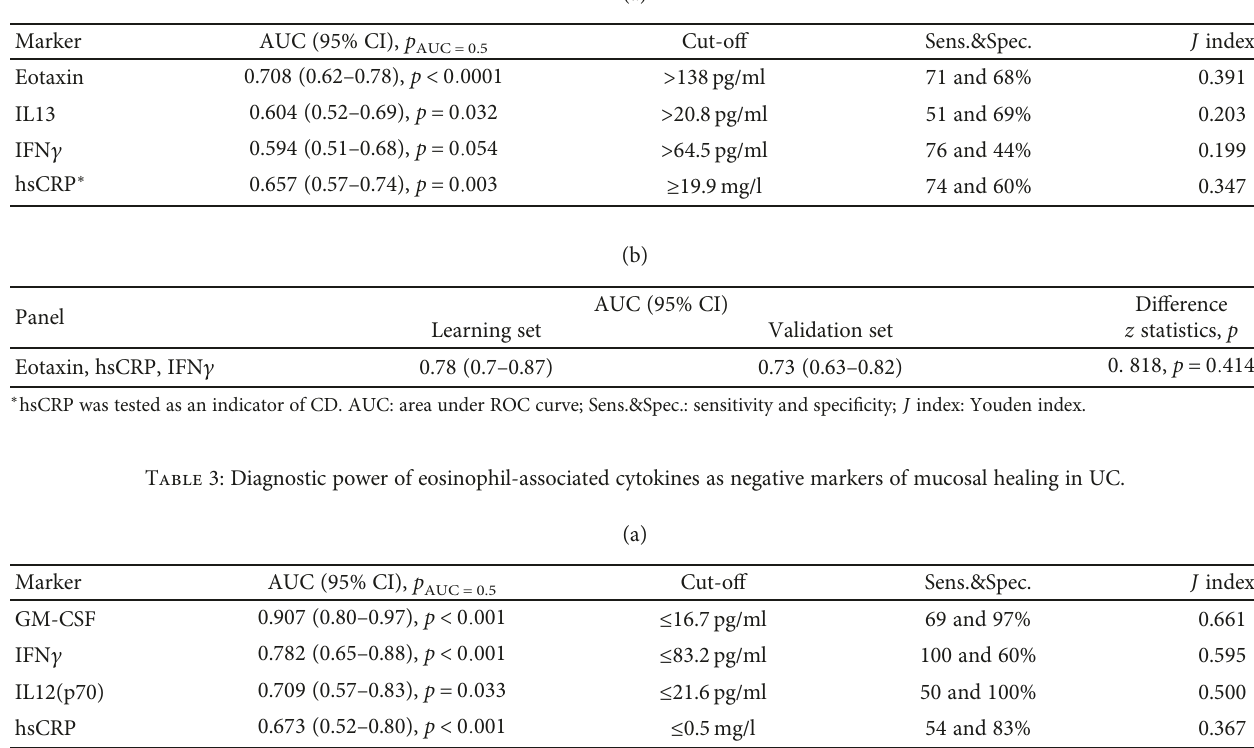
Figure 2: Eosinophil-associated cytokines as biomarkers in IBD-receiver operating characteristic (ROC) curves. (a) Eosinophil-associated cytokines as markers di ff erentiating active UC and CD; (b) eosinophil-associated cytokines as mucosal healing markers; (c) eosinophil- associated cytokines as markers di ff erentiating active IBD and Table 2: Diagnostic power of eosinophil-associated cytokines as markers di ff erentiating active UC from CD. (a)